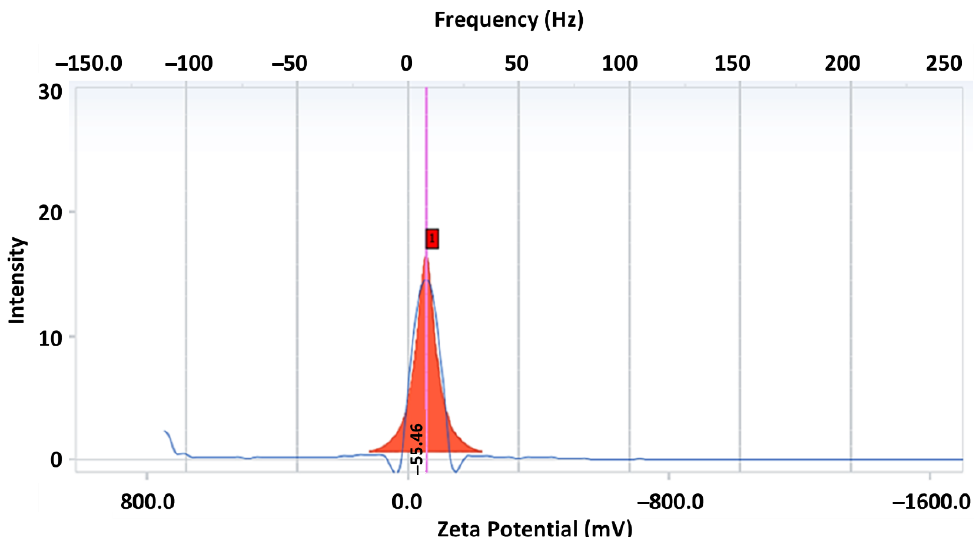
Figure 5. Zeta potential of synthesized AgNP from leaf extract of C.